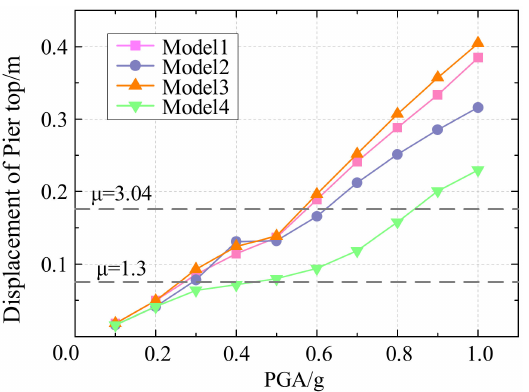
Figure 15. Comparison of pier displacement demand using various bearing